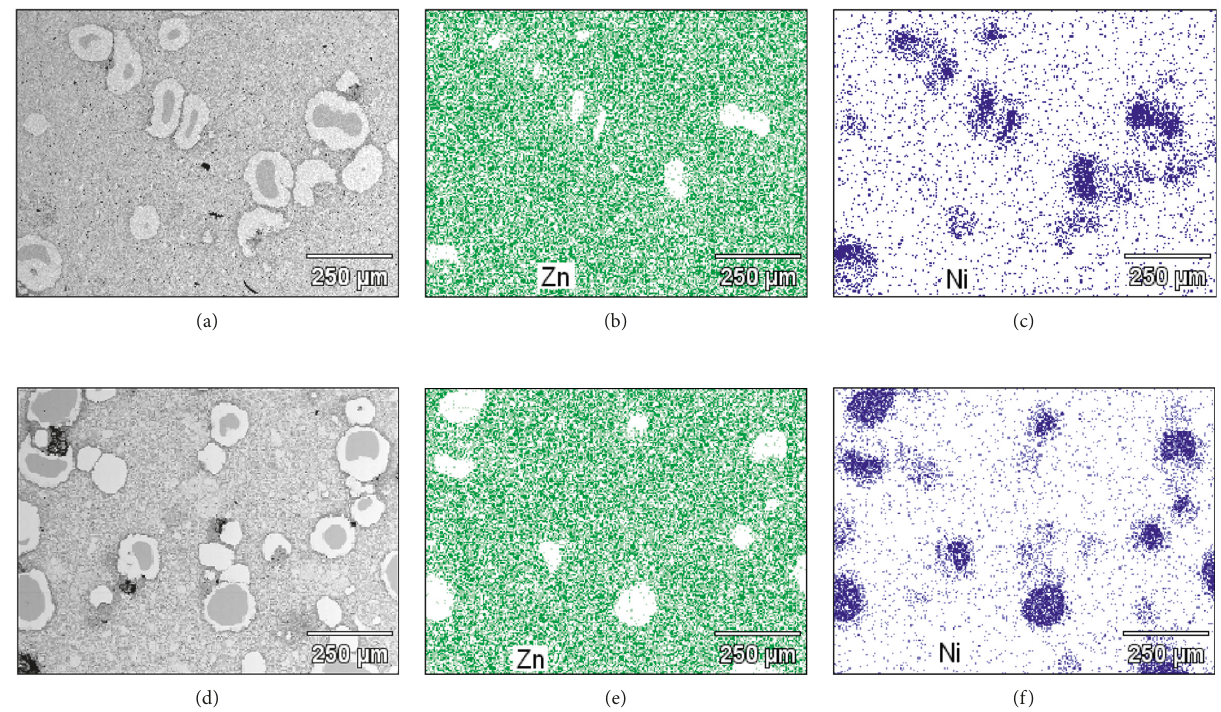
Figure 9: SEM-EDS elemental maps for the Zn-Ni x sintered powder alloy obtained by X-ray fluorescence. (a) SEM microstructure of the Zn-Ni 5 alloy and its elemental map for Zn (b) and for Ni (c) and (d) SEM microstructure of the Zn-Ni 10 alloy and its elemental map for Zn (e) and for Ni (f).